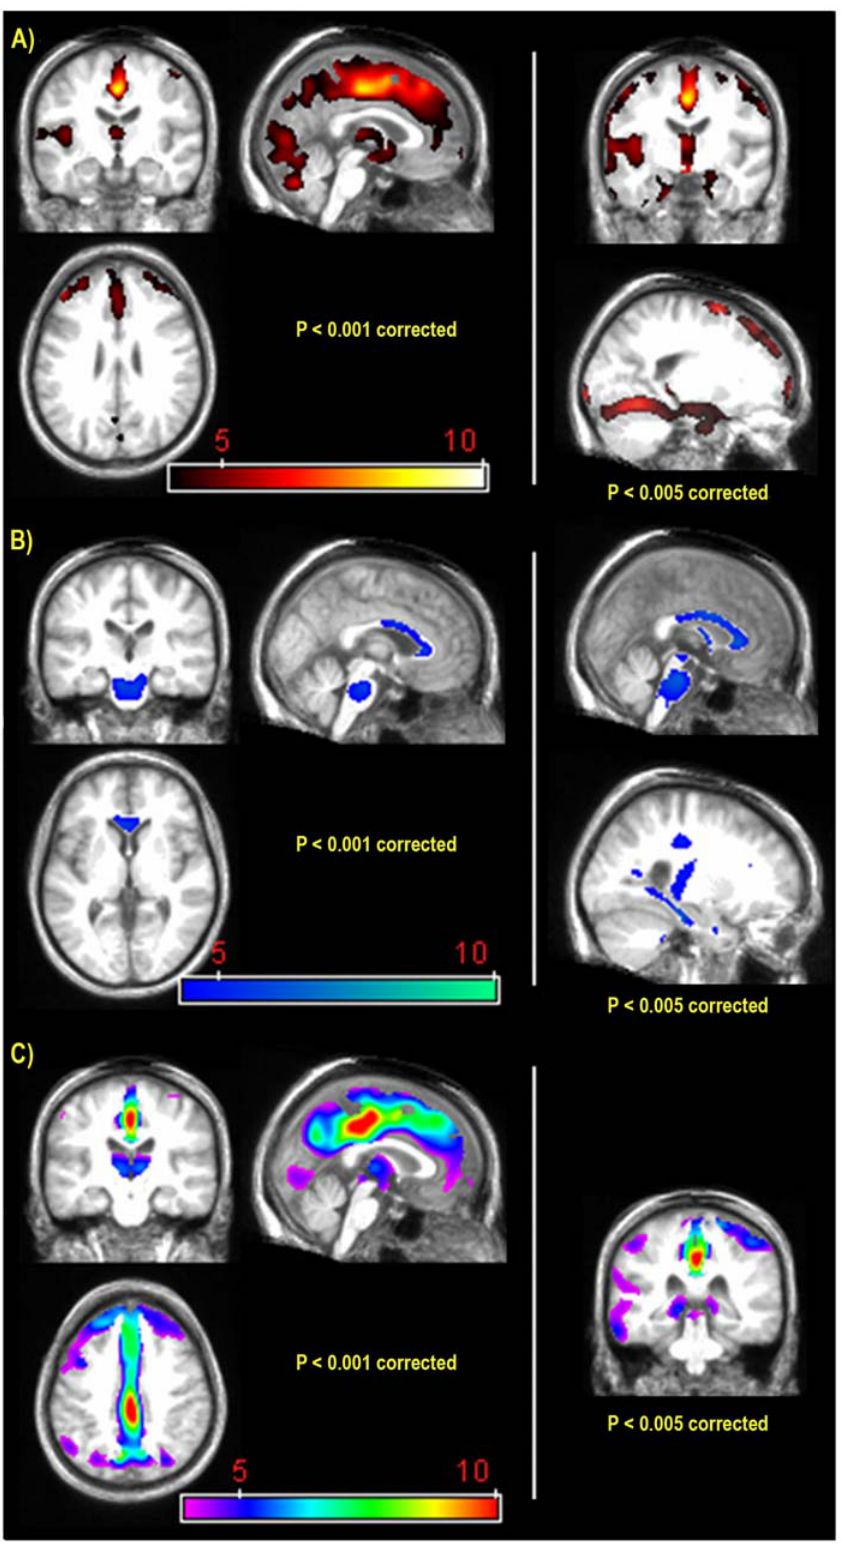
Figure 1. GM (A), WM (B), and metabolism (C) abnormalities in Korsakoff’s syndrome compared with healthy subjects (k . 200 voxels). Between group comparisons conducted with the SPM5 two-sample t-test routine. False Discovery Rate correction. On the coronal slice, the right is displayed on the right. The colored bar represents the t value of significant voxels.